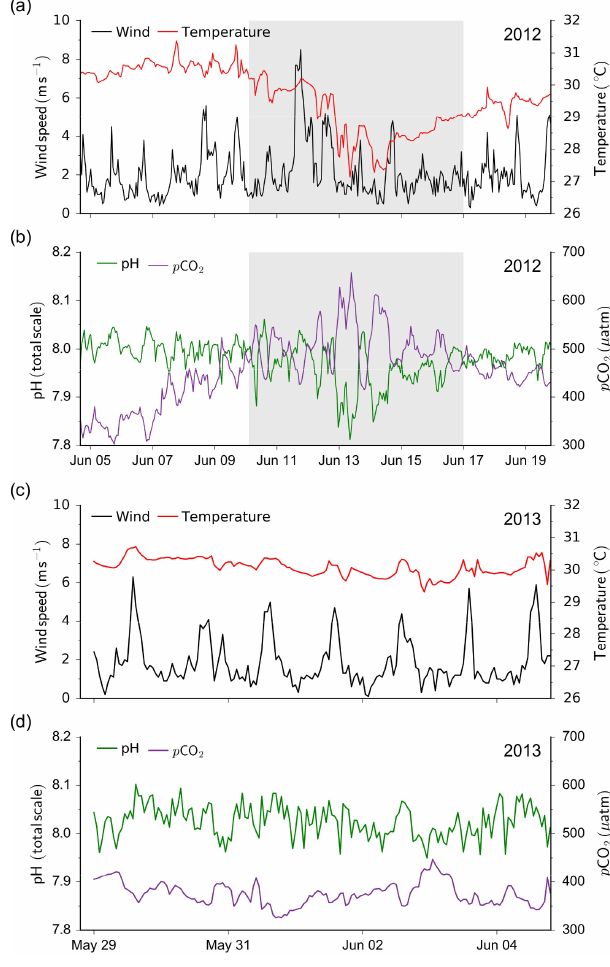
Figure 2. Measured parameters (wind speed, SWT, pH and p CO 2 ) during the non-upwelling seasons of June 2012 (a, b) and May– June 2013 (c, d) at Bahía Culebra. Shaded area in panels (a, b) indicates the 2012 upwelling-like